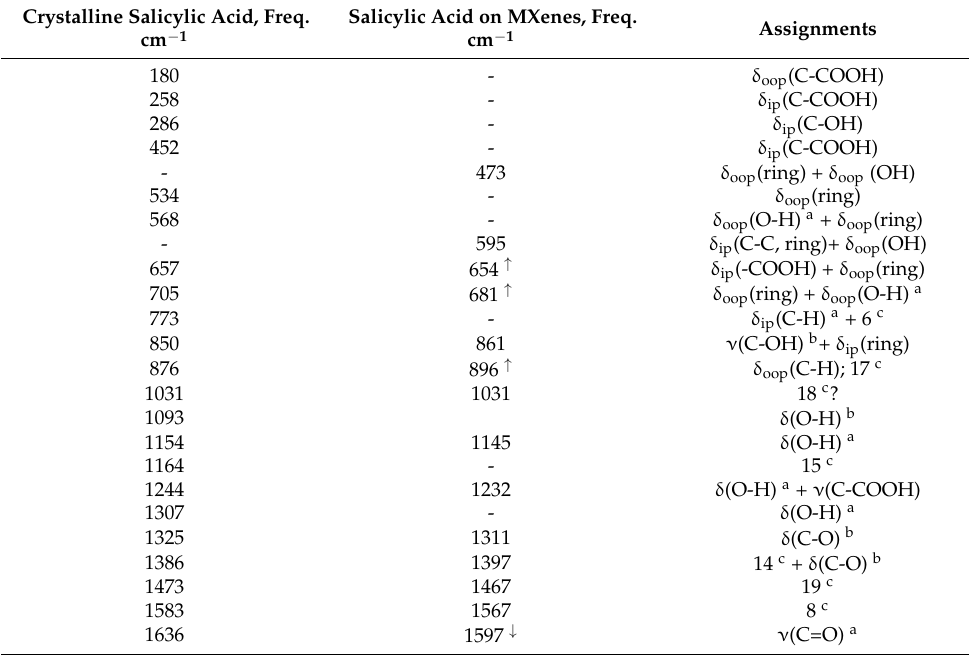
Table 3. Vibrational frequencies of crystalline salicylic acid and SA–MXene complex.